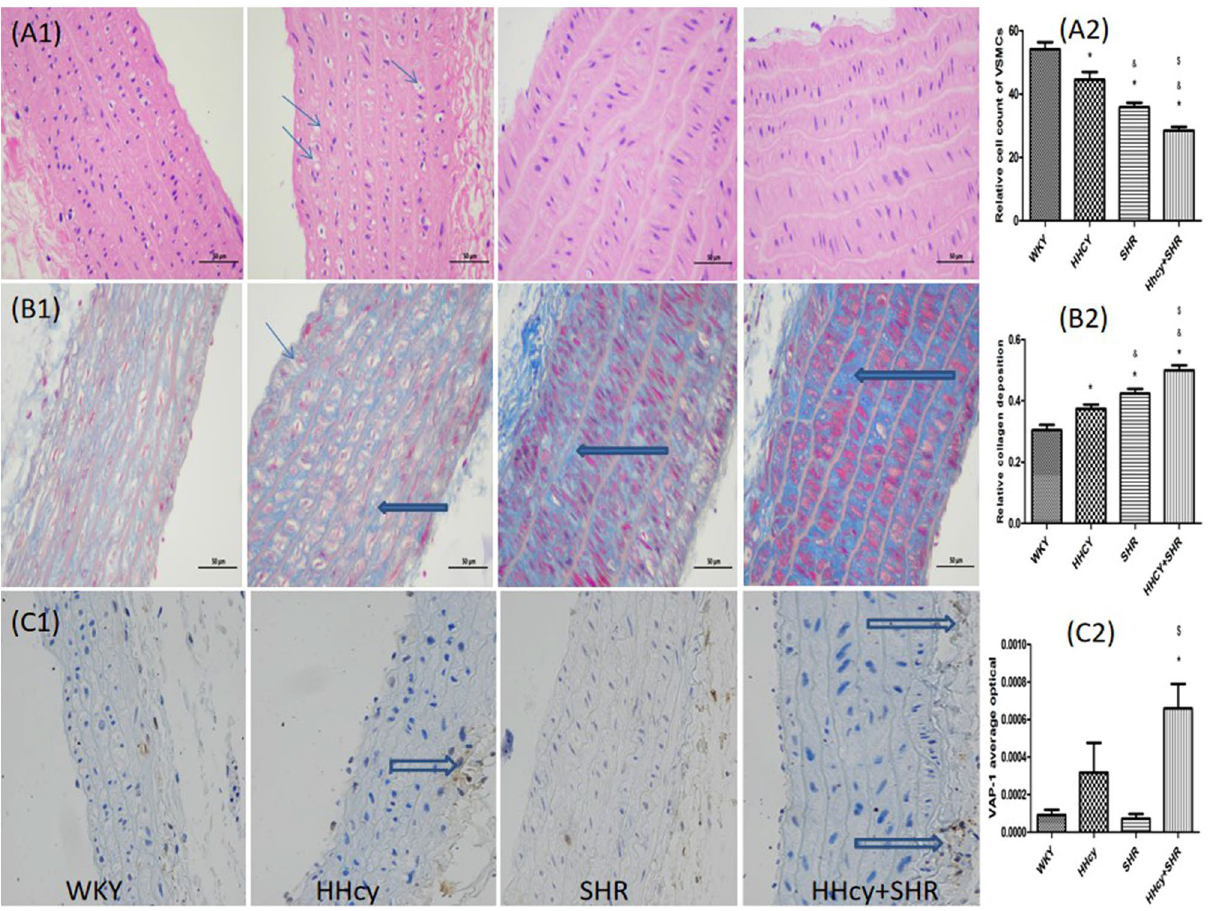
Figure 3. Representative images of hematoxylin and eosin (HE) staining, Masson’s trichrome staining and immunohistochemical staining. Thin blue arrows indicate vacuolar degeneration of vascular smooth muscle cells (VSMCs) in rat aortic wall. Thick blue arrows indicate blue collagen deposition. Thick hollow arrows indicate brown particles of vascular adhesion protein-1 (VAP-1). ( A 1 ) Representative images of HE staining. ( B 1 ) Representative images of Masson’s trichrome staining. ( C 1 ) Representative images of VAP-1 immunohistochemical staining. ( A 2 ) Relative cell count of VSMCs. ( B 2 ) Semi-quantitative analysis of collagen deposition. ( C 2 ) The average optical density value (AO value) of VAP-1. (Original magnification of rat aortic wall, × 400, in Wistar-Kyoto (WKY) group, hyperhomocysteinemia (HHcy) group, spontaneously hypertensive rat (SHR) group and HHcy + SHR group. Values represent means ± SD, * P < 0.05 vs. WKY group, $ P < 0.05 vs. SHR group, δ P < 0.05 vs. HHcy group, n =